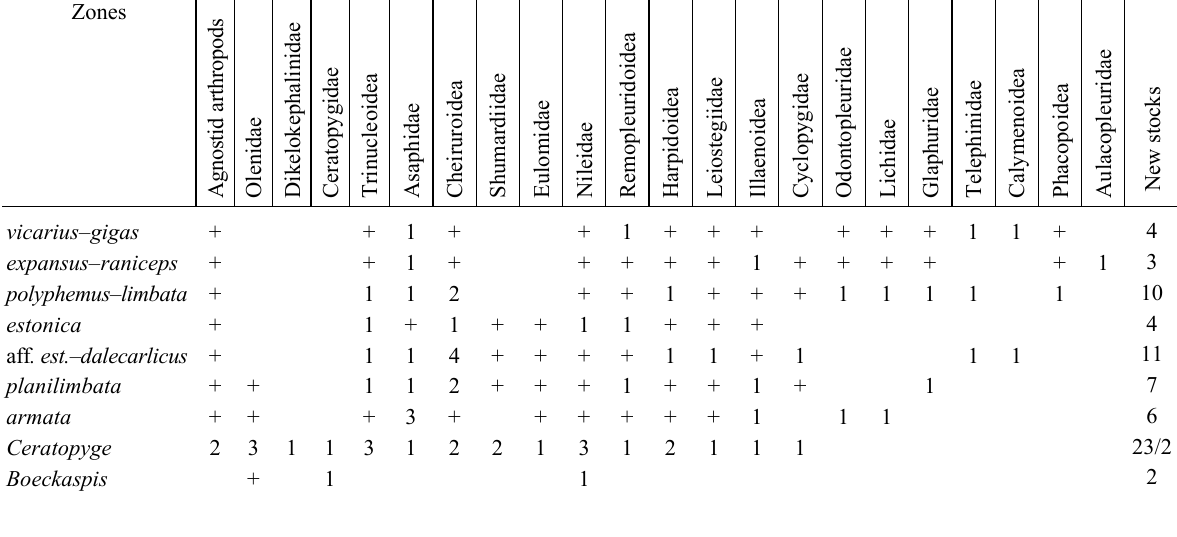
Table 1. Presence (+) and supposed minimum immigrations of new stocks (1, 2, 3, 4, for a minimum number of separate immigrations) of trilobites. Glaphuridae is used instead of the common Raymondinidae because of the inadequate preservation of